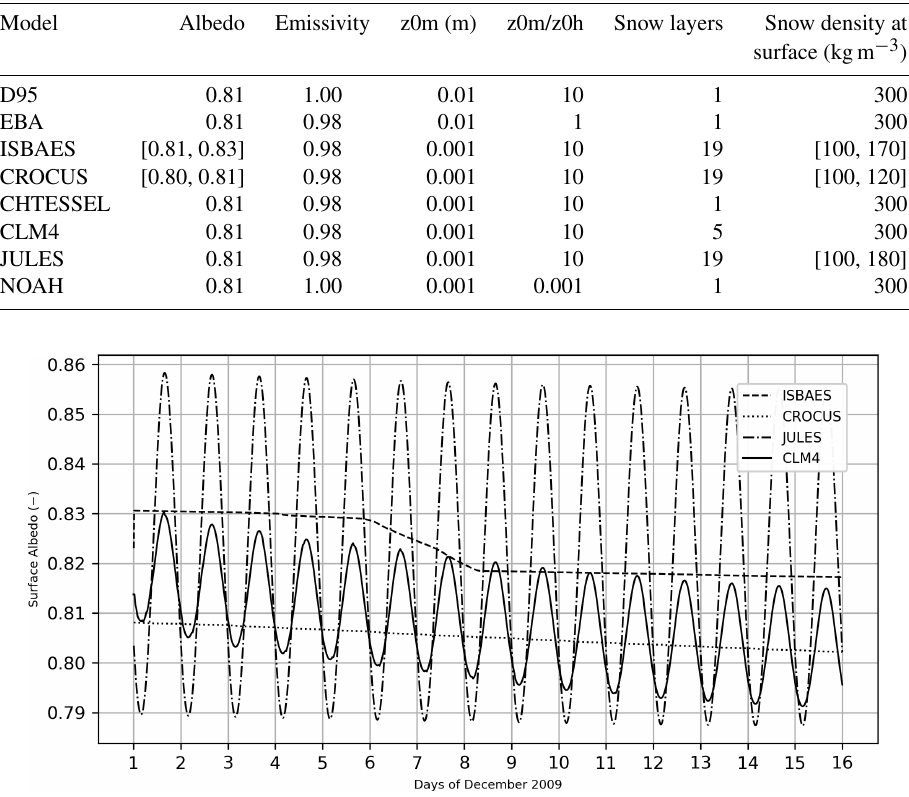
Figure 4. Time evolution of surface albedo for ISBAES, CROCUS, JULES, and CLM4 models.